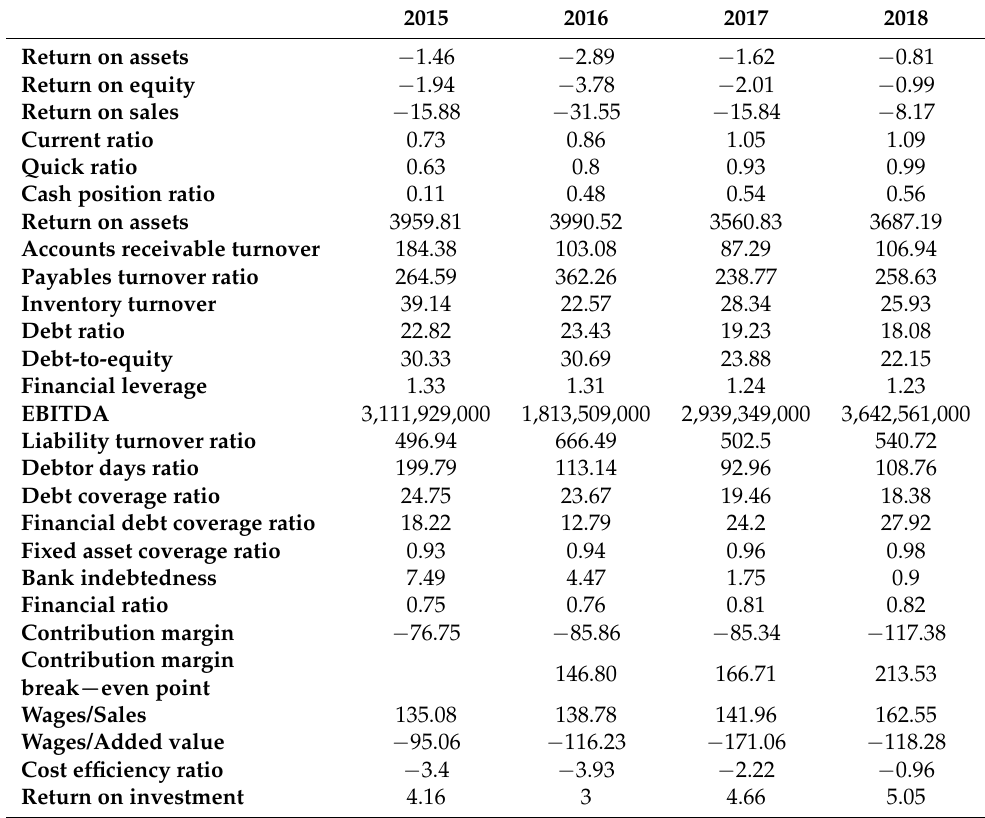
Table 32. Results of ratios for the company Spr á va železnic, st á tn í